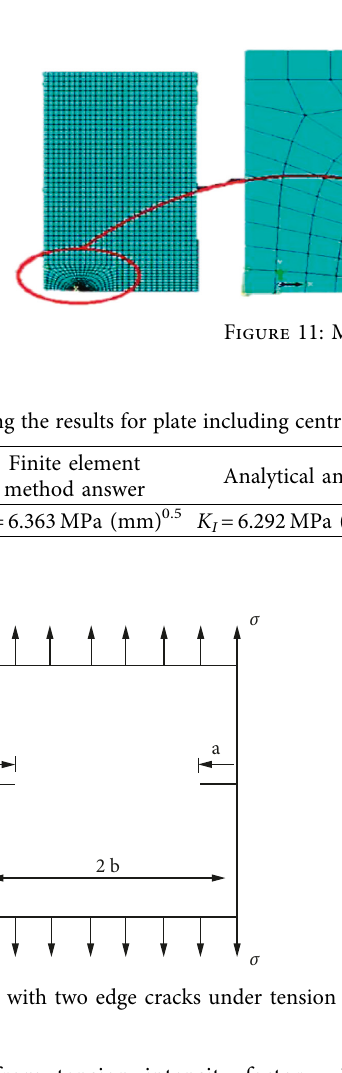
Figure 10: Using symmetry in finite element modeling of first simple issue [24].